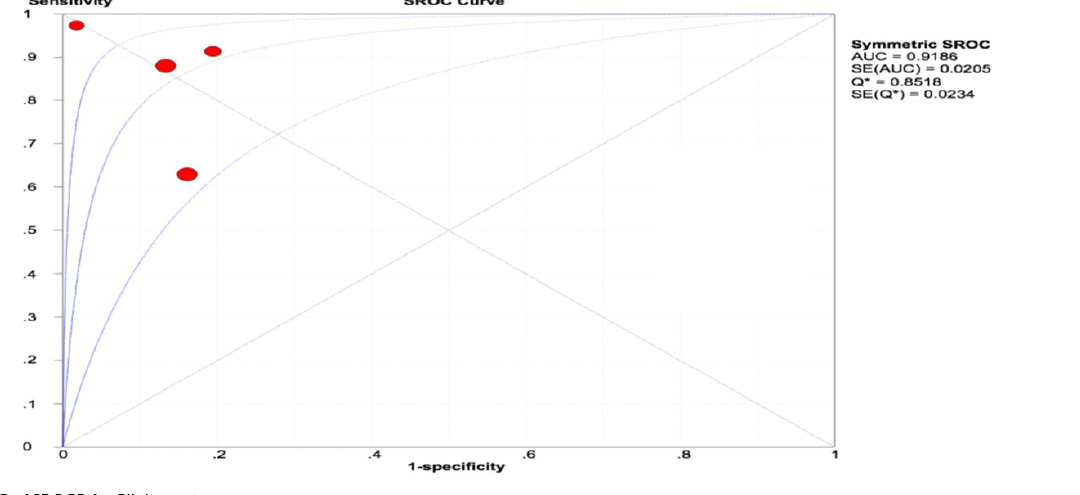
Figure 9. SROC of SF-BCB for PJI